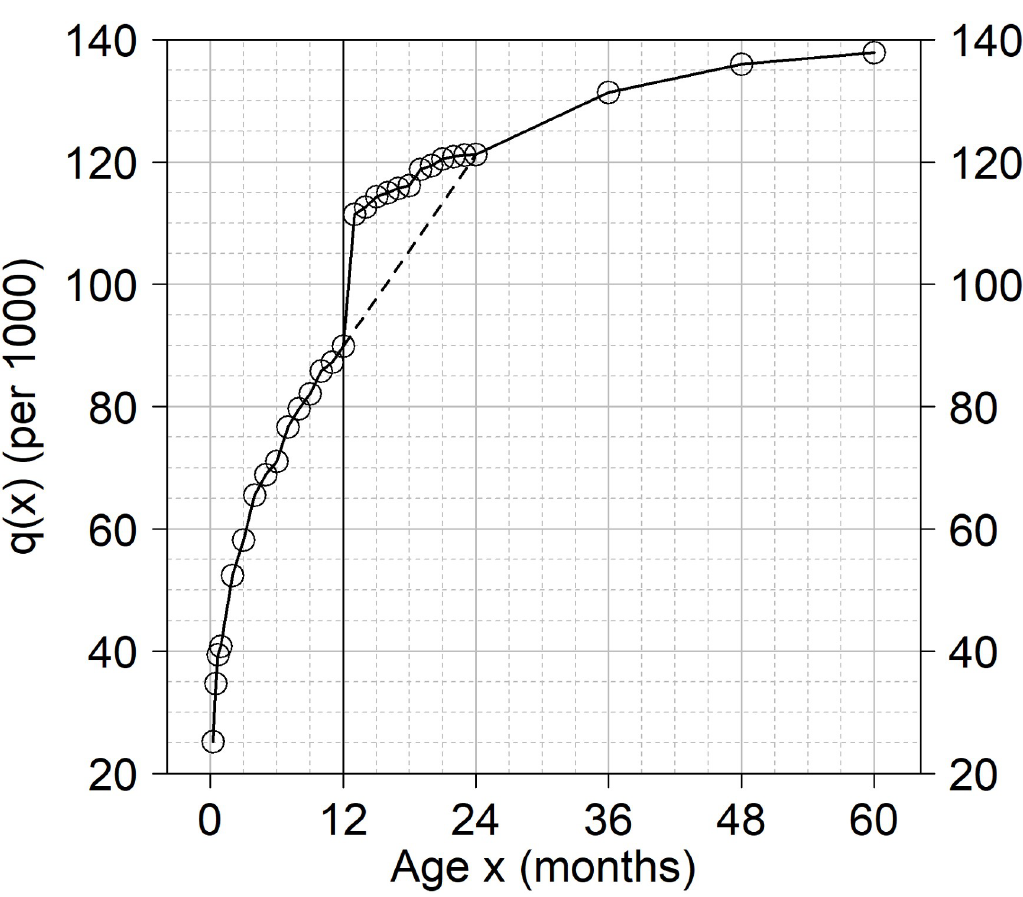
Fig 1. Percentage of under-5 deaths at ages 1 to 23 months in DHS surveys. Percentage estimated for each of the 204 selected surveys. Neonatal deaths not represented in the